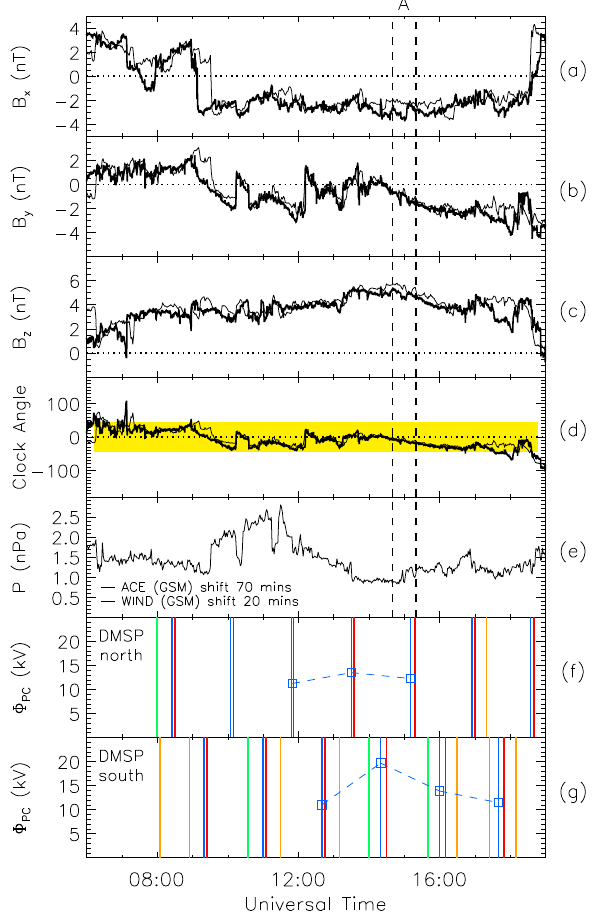
Fig. 2. The variation in IMF parameters ( a ) B x , ( b ) B y , ( c ) B z , and ( d ) clock angle, between 06:00 and 19:00 UT on 11 Novem- ber 1998. The bold lines represent the GSM variations measured by the ACE spacecraft, shifted by 70min. The thin lines represent the GSM variations measured by the WIND spacecraft, shifted by 20min. The yellow shaded region in panel (d) highlights the re- gion between − 45 ◦ and 45 ◦ clock angle. Panel ( e ) presents the solar wind dynamic pressure measured by the WIND spacecraft, shifted by 20min. Panels ( f ) and ( g ) present the timings of DMSP overpasses of the Northern and Southern Hemisphere ionospheres, respectively. The passes are colour-coded as follows; DMSP-F11 (orange), DMSP-F12 (green), DMSP-F13 (blue), and DMSP-F14 (red). The blue squares joined by dashed lines present the poten- tials measured between the centres of the reverse convection cells by DMSP-F13 at these times. The vertical dashed lines in panels (a) to (e) delineate interval A, studied in detail in this paper (14:40 to 15:20